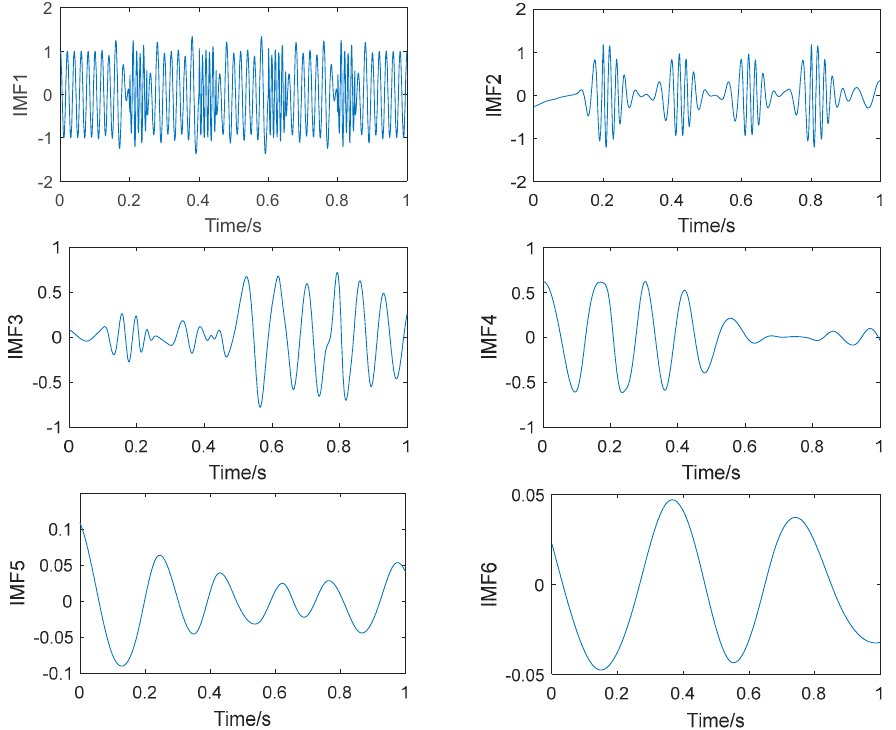
Figure 4. Simulation signal y ( t ) empirical mode decomposition (EMD) results.